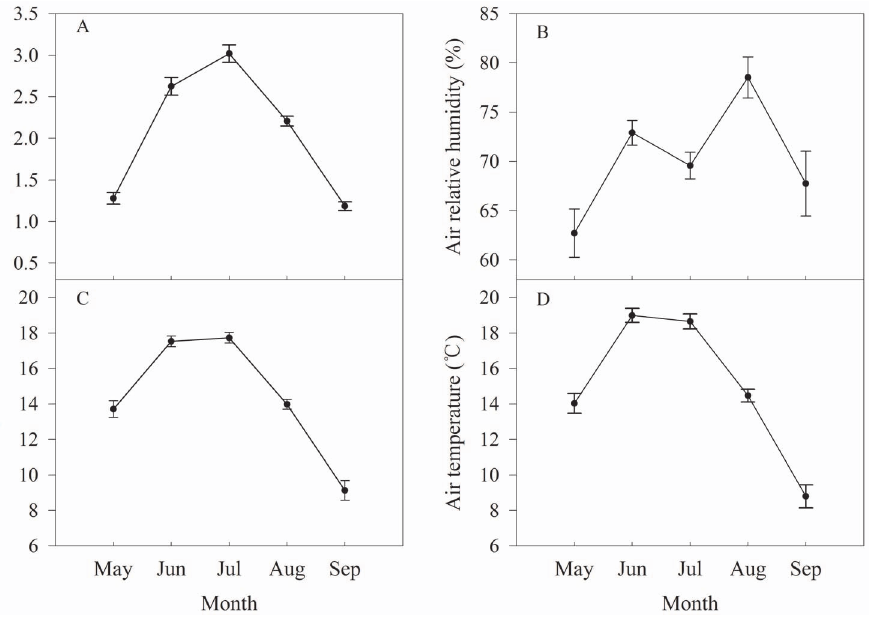
Figure 3. Seasonal changes in (A) stem respiration per unit surface area (R S ), (B) air relative humidity, (C) stem temperature and (D) air temperature. For each month, all the 3-hourly measurements were averaged for the six sample trees from 2010 to 2012. The resulting standard errors are represented by the bars.